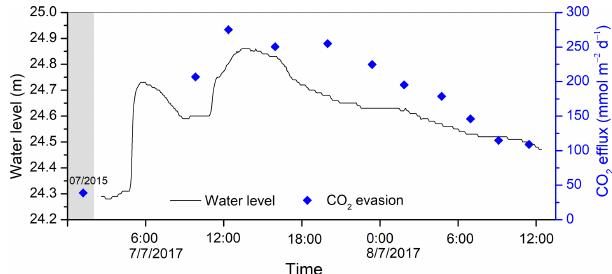
Figure 8. Temporal variation in CO 2 efflux during a high-discharge flood event in the Wuding River at the Baijiachuan gauge (refer to Fig. 1 for its